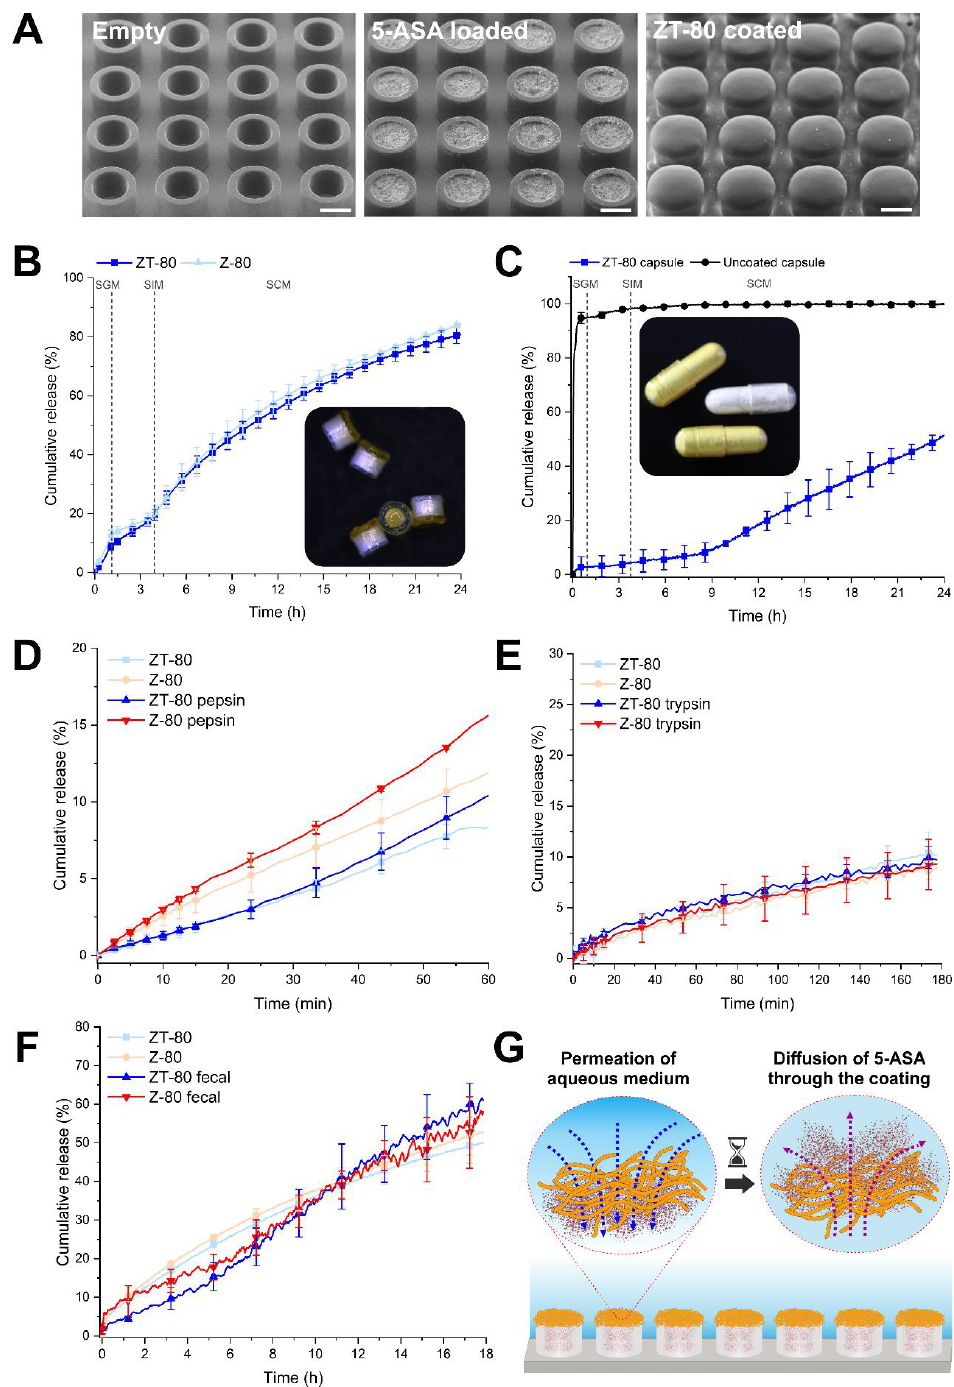
Figure 3. ( A ) SEM images of empty MCs loaded with 5-ASA and coated with ZT-80. ( B ) Release of 5-ASA in biorelevant media from MCs coated with ZT-80 and Z-80. Inset depicts optical microscopy images of ZT-80-coated MCs loaded with 5-ASA. ( C ) Release of 5-ASA from uncoated and ZT-80- coated capsules in biorelevant media. Inset depicts uncoated and ZT-80-coated capsules loaded with 5-ASA. ( D – F ) Release of 5-ASA from ZT-80 and Z-80-coated MCs in SGM holding pepsin ( D ), SIM holding trypsin ( E ), and SCM holding rat fecal contents ( F ). ( G ) Illustration of the suggested mechanism for the release of 5-ASA from ZT-80-coated MCs. Scale bars represent 200 µ m. Data are presented as mean ± SD and n =